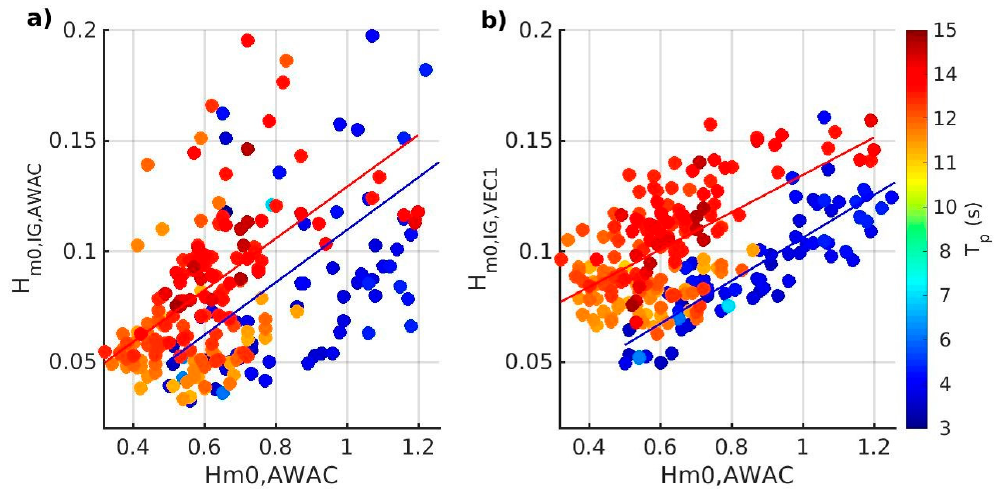
Figure 5. IG wave height, ( a ) at the AWAC (o ff shore), ( b ) at VEC1 (surf zone), versus sea-swell wave height at the AWAC, colour coded by the peak period. Correlation coe ffi cients ( R ) are ( a ) 0.50 for swell (red) and 0.48 for wind-sea (blue), ( b ) 0.61 for swell and 0.89 for wind-sea. The frequency distribution of IG energy and the nodal structure vary with cross-shore location.